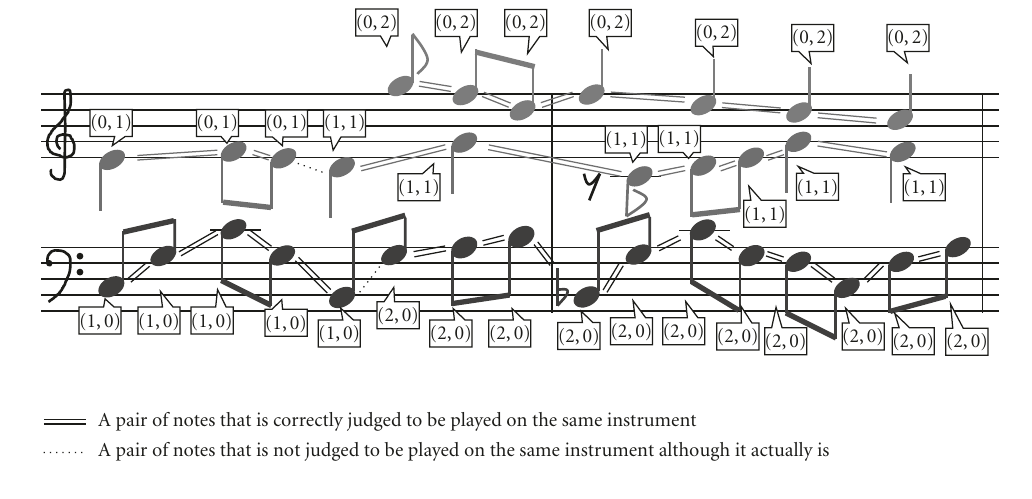
Figure 4: Example of judgment of whether notes are played on the same instrument. Each tuple (a,b) represents s h ( n k ) = a and s l ( n k ) = b.